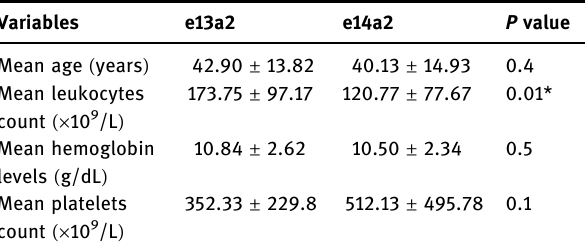
Table 3: Distribution of patients exhibiting e13a2 and e14a2 tran - scripts according to gender and di ff erent ranges of age, hemo - globin levels, and total leukocyte and platelets